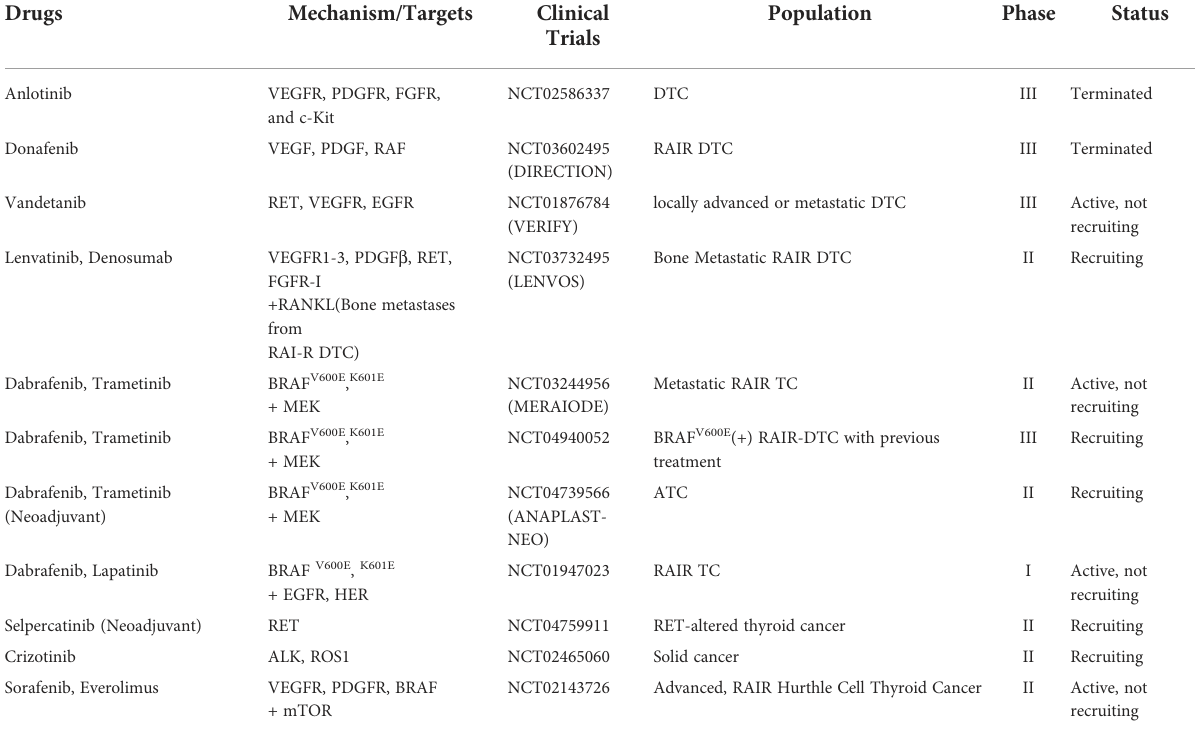
TABLE 3 Ongoing TKIs clinical trials for RAIR-DTC and